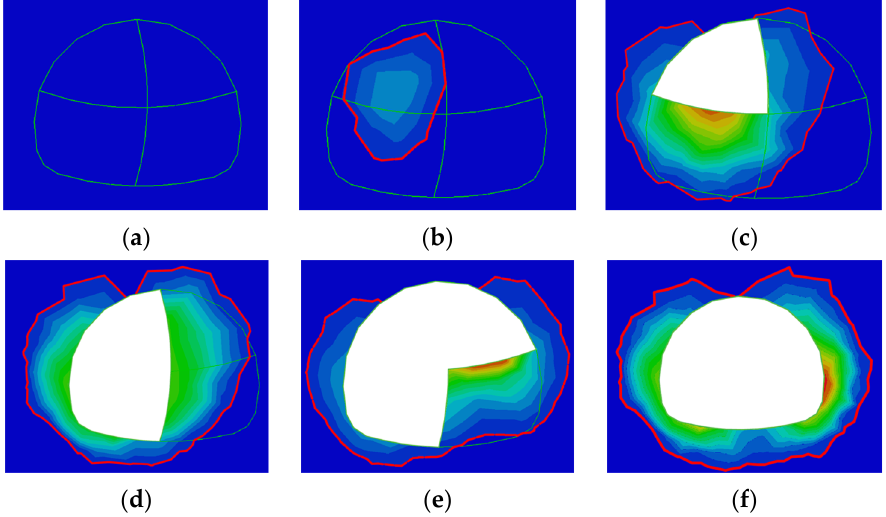
Figure 9. Development of the plastic zone. ( a ) step 43; ( b ) step 46; ( c ) step 54; ( d ) step 60; ( e ) step 76; ( f ) step 80.